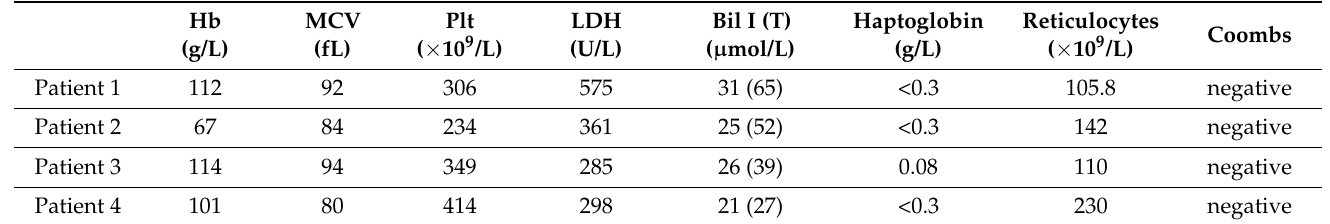
Table 2. Summarized patients’ laboratory data upon diagnosis of hemolytic anemia on